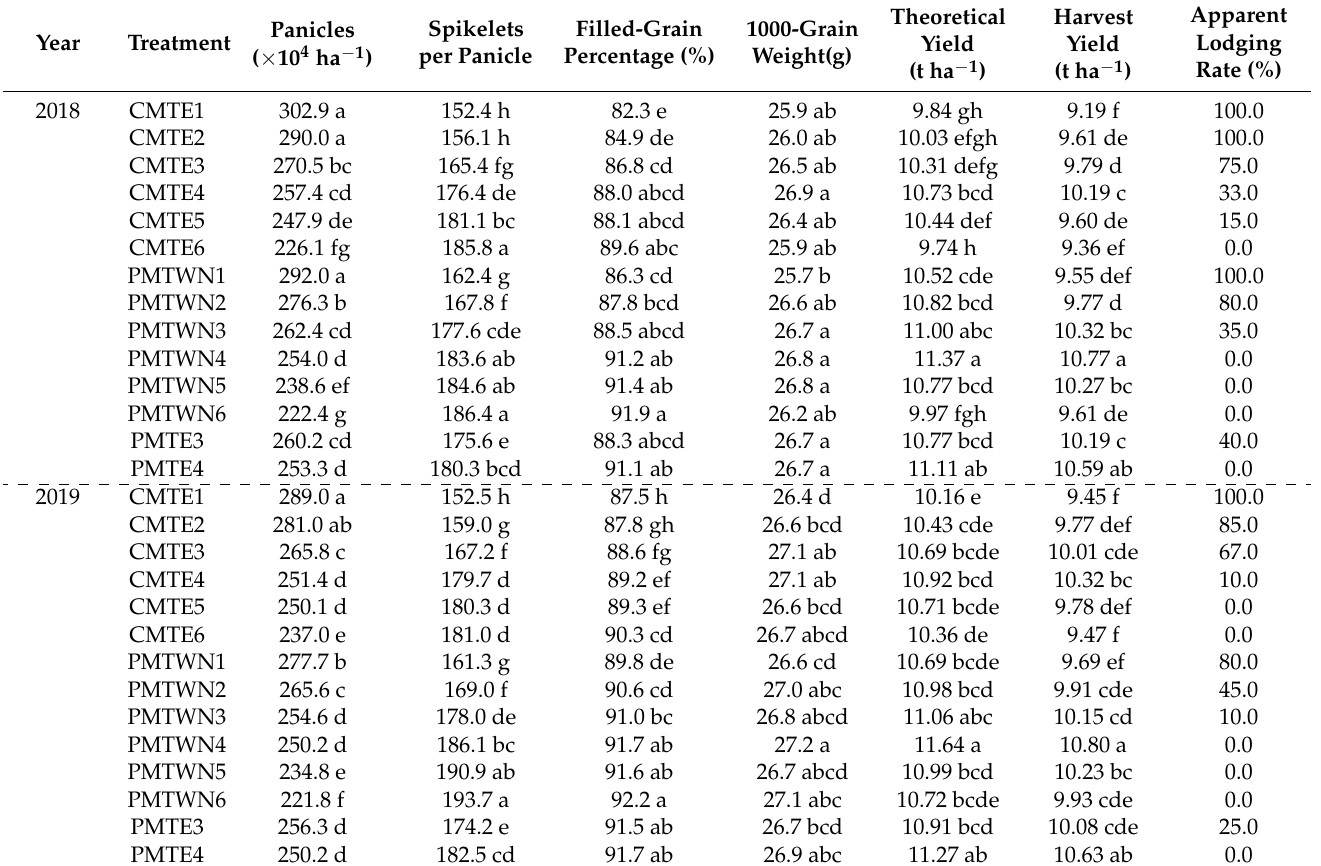
Table 2. Yield and its components of rice under different mechanical transplanting methods and planting